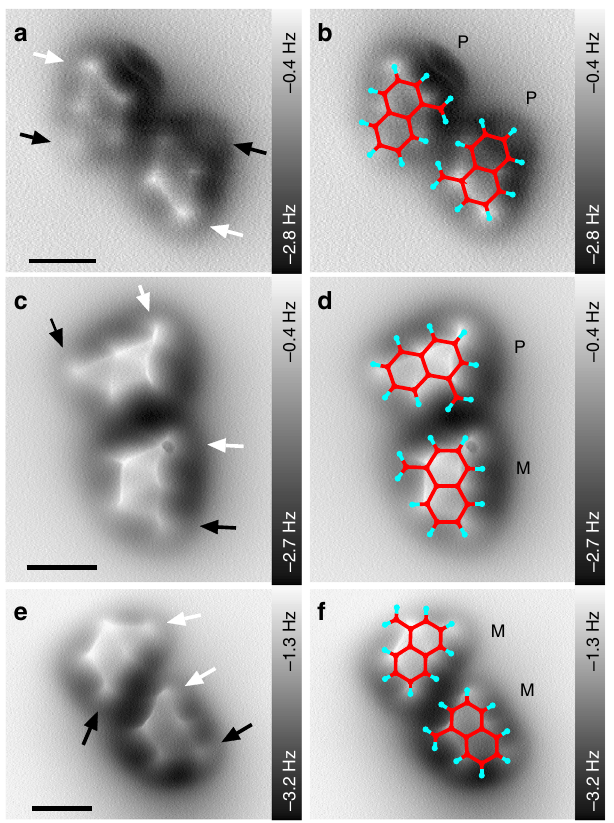
Fig. 5 Constant height AFM scans of [123]tetramantane dimers. a , b ( P , P )- [123]tetramantane dimers. c , d ( M , P )-[123]tetramantane dimers. e , f ( M , M )-[123]tetramantane dimers. Tilting of the molecules is indicated by black and white arrows (as in Fig. 4). b , d , f AFM scans overlaid with molecular structures. For clarity only the plane containing the two speci fi c hydrogens is plotted (cf. Fig. 4). Scale bars: 0.5 nm absolute con fi guration and the precise determination of mole- cular orientation. An overlay of the molecular structures is shown in (c, d). Images (a, c) were taken before, while images (b, d) were obtained after deliberately manipulating the molecules with the AFM tip. Therefore, the molecular cluster has been imaged in STM mode while the gap voltage and tunneling current were systematically changed until manipulation of the molecules was observed. Fig. 6b reveals that fi ve of the six molecules have been rotated by this procedure. Comparing the arrangement of the molecules before and after manipulation reveals very similar patterns of close contacts between the molecules, showing that intermolecular LD interactions have a signi fi cant in fl uence on the process of molecular assembly.